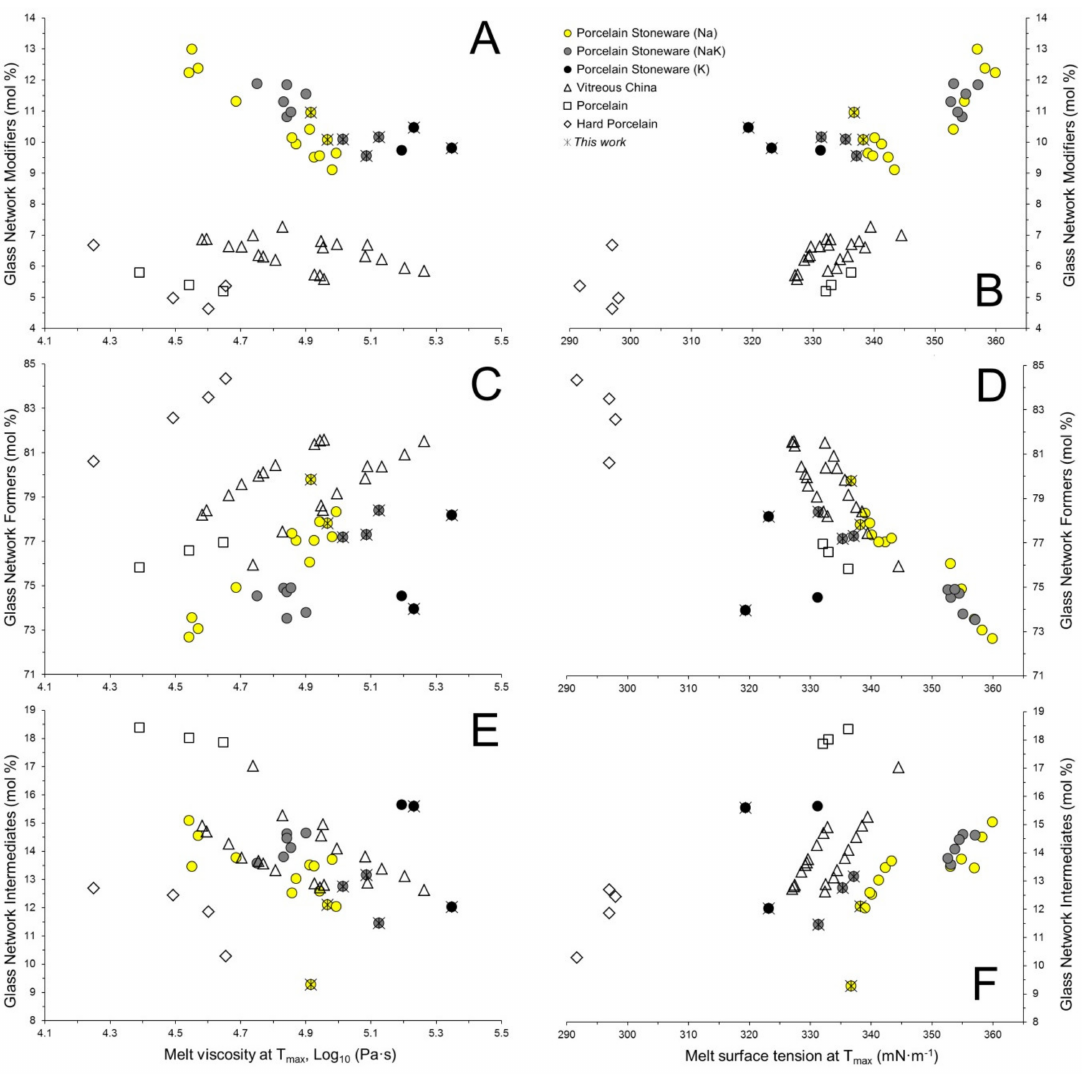
Figure 7. Physical properties at the maximum firing temperature ( T max ) of the vitreous phase in function of its chemical composition. Glass Network Modifiers versus viscosity ( A ) and surface tension ( B ); Glass Network Formers versus viscosity ( C ) and surface tension ( D ); Glass Network Intermediates versus viscosity ( E ) and surface tension ( F